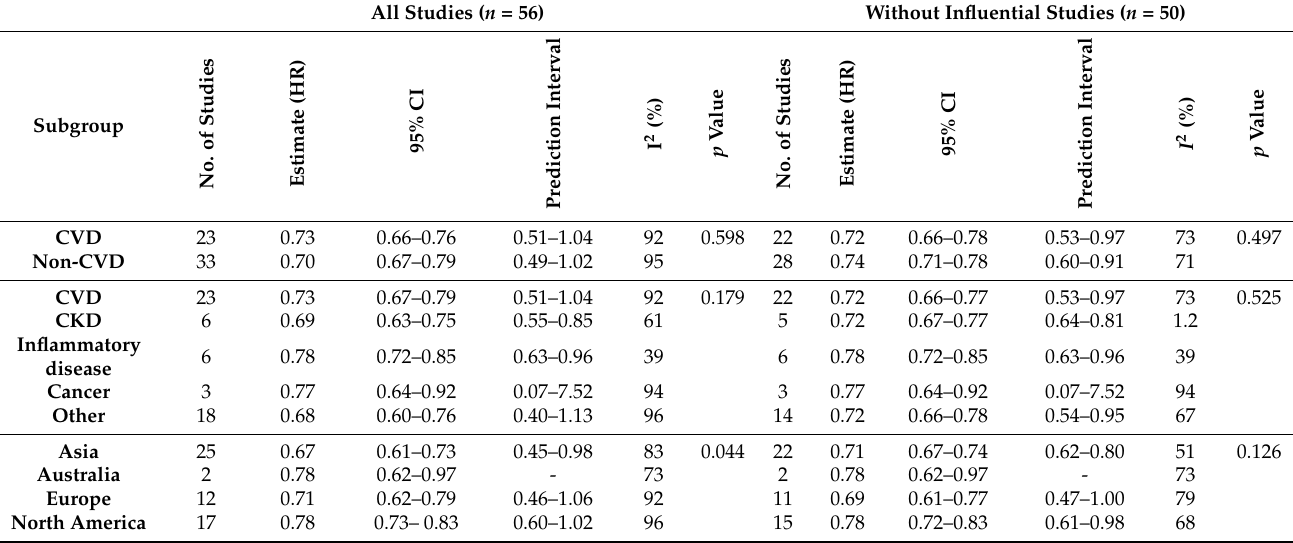
Table 2. Sensitivity analyses of the association between statin use and all-cause mortality.